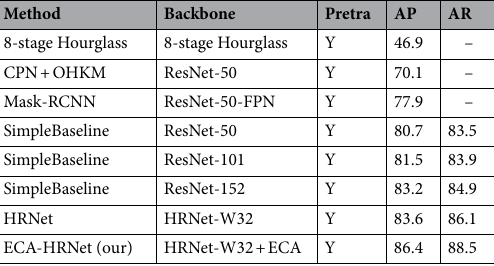
Table 6. Comparison of results on KDSJ test set (Pretra = backbone pretrained on the COCO2017 keypoint task; OHKM = online hard keypoint mining 8 ).